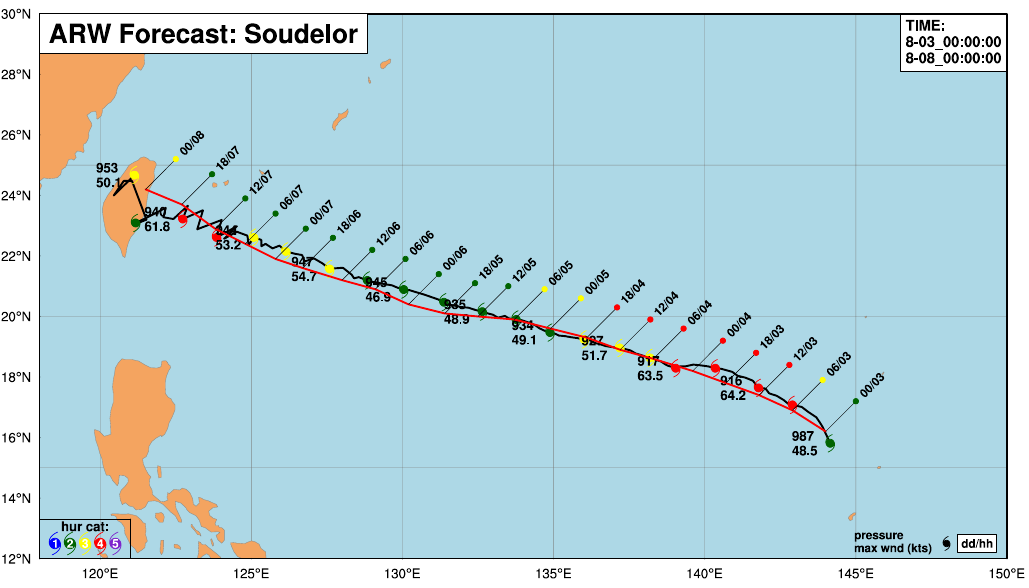
Figure 6. Track of Typhoon Soudelor (2015) with every 6-h position from 0000 UTC 3 August to 0000 UTC 8 August 2015 based on the JTWC best track data (red line) and simulation (black line). The solid circles with different colors represent different categories. The solid circles of the JTWC best track data are plotted northeast to the track with the information of date.